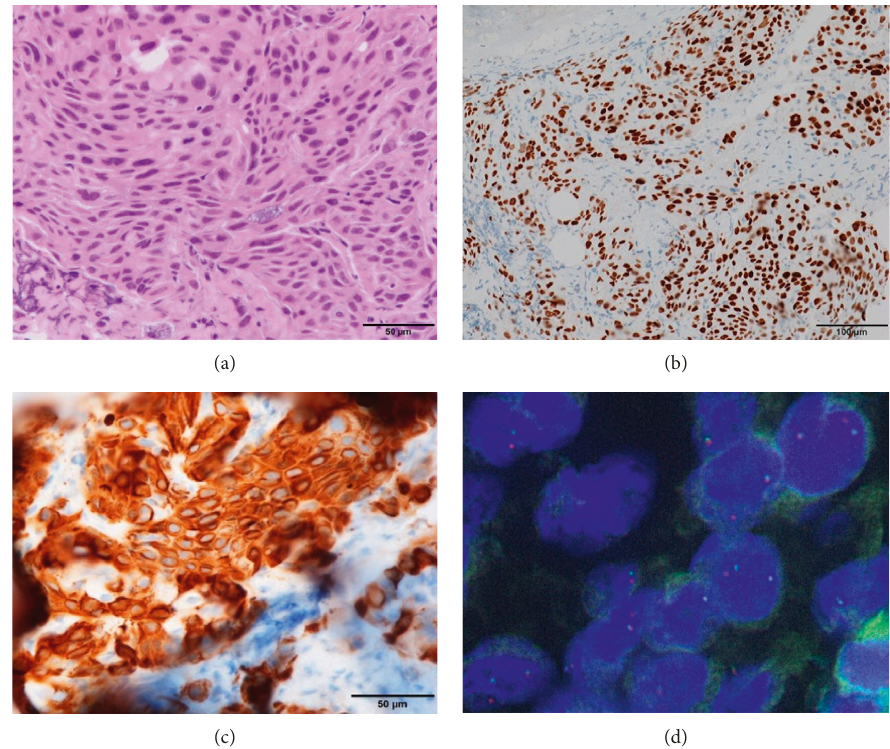
Figure 2: Pathological examinations. (a) Hematoxylin and eosin staining showed moderately differentiated malignant cells with abundant cytoplasm connected with intercellular bridge. Immunohistochemical staining revealed that the tumor cells were strongly positive for p40 (b) and CK5/6 (c). (d) Fluorescence in situ immune-hybridization signals of ALK. Split red and green signals can be